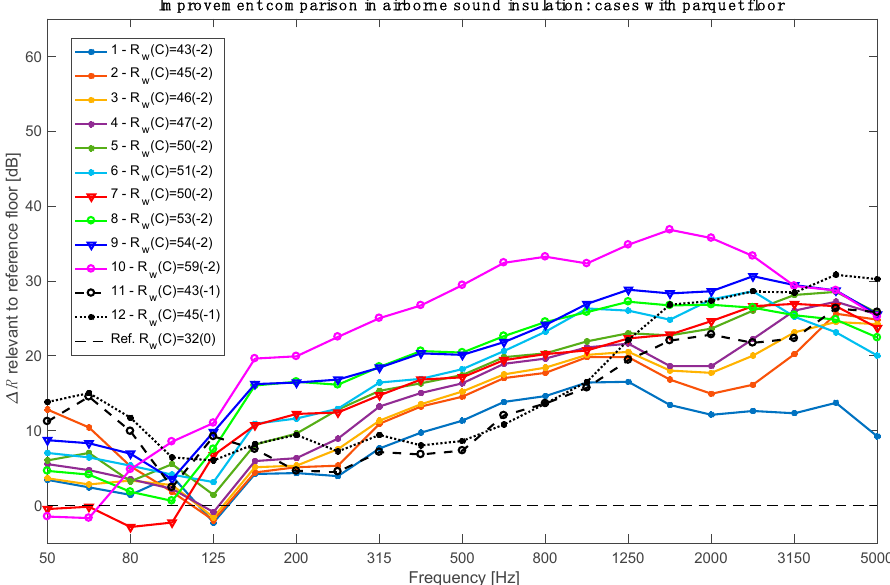
Figure 2. Improvements provided in terms of airborne sound reduction index ∆ R of the test floors relative to the reference CLT floor.